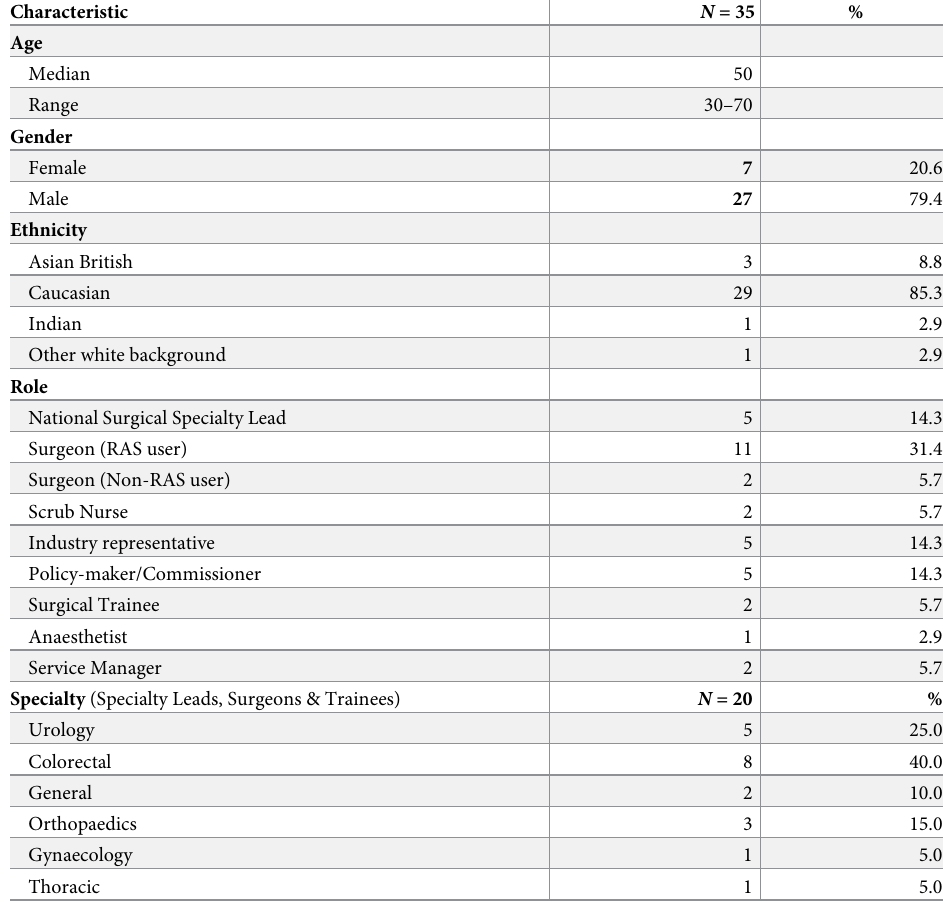
Table 1. Participant demographics. Note that age, gender and ethnicity was not reported by one participant.